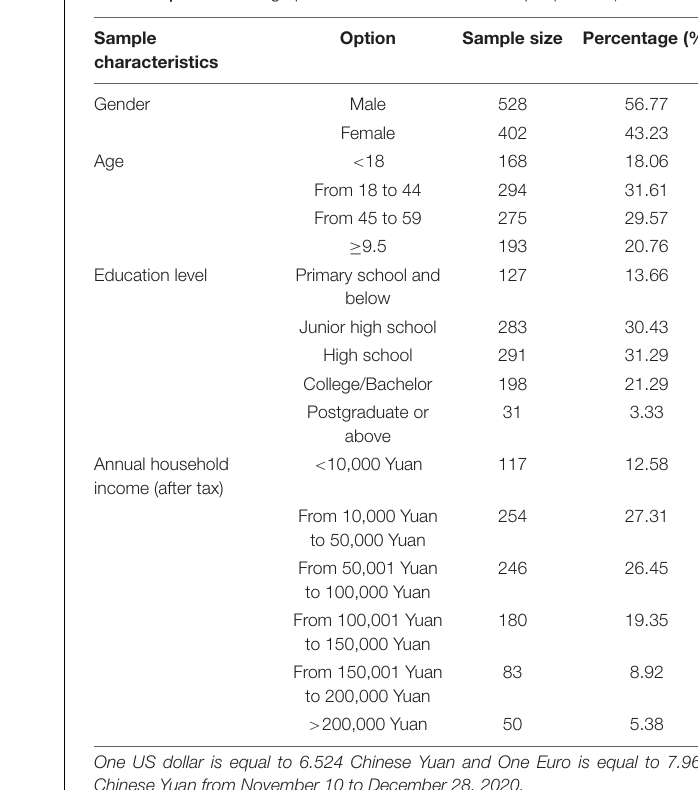
and statistically significant ( p < 0.05) positive correlations were reported (as described in Table 3 ). Discriminant validity was also assessed by examining the average variance extracted estimates (AVE). The discriminant validity analysis evaluates the extent to which the items are not theoretically correlated. The data did not have any problems of discriminant validity because the value of the square root of AVE was greater than its correlation with other constructs (Kline, 2005).